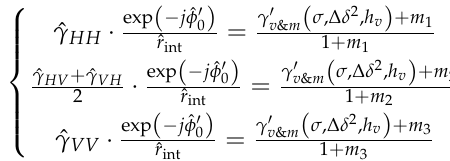
The last stage of the workflow is to solve the nonlinear equations with three unknown ther processing. Theoretically, there are two intersection points between the coherence parameters, which is the forest parameter estimation. Considering that the magnitudes of line and the internal circle. One is the ground coherence point, and the other is the so- the SVD and PD coherences are more likely to be selected as the internal circle radius and called false solution. Practically, the further a polarimetric coherence locates toward the the reciprocal theory assumes ˆ γ HV ≈ ˆ γ VH [23–25], thus, the inverse problem can be solved ground coherence, the lower its ground-to-volume ratio. Therefore, the right solution can be selected by the intersection with a long distance from the polarimetric coherence point by the following equation. with the least ground backscatter in the visible scale. Therefore, two parameters ( are determined in the above inverse problem where the phase component can be further used for the tomographic reconstruction. This is outside the scope of this paper. However, it is worth noting that during the estimation of the ground coherence, the corresponding ground-to-volume ratio is approximated as infinite, which means in this condition, the polarimetric channel introduces two DOFs without any extra unknown parameter. There- fore, after the determination of the ground coherence point, the ten-dimensional inverse As to estimate the unknowns in Equation (15), the iterative optimization procedure is problem in Equation (12) can be simplified as carried out by minimizing the least square distance between the DF-RMoG predicted and the observed coherences